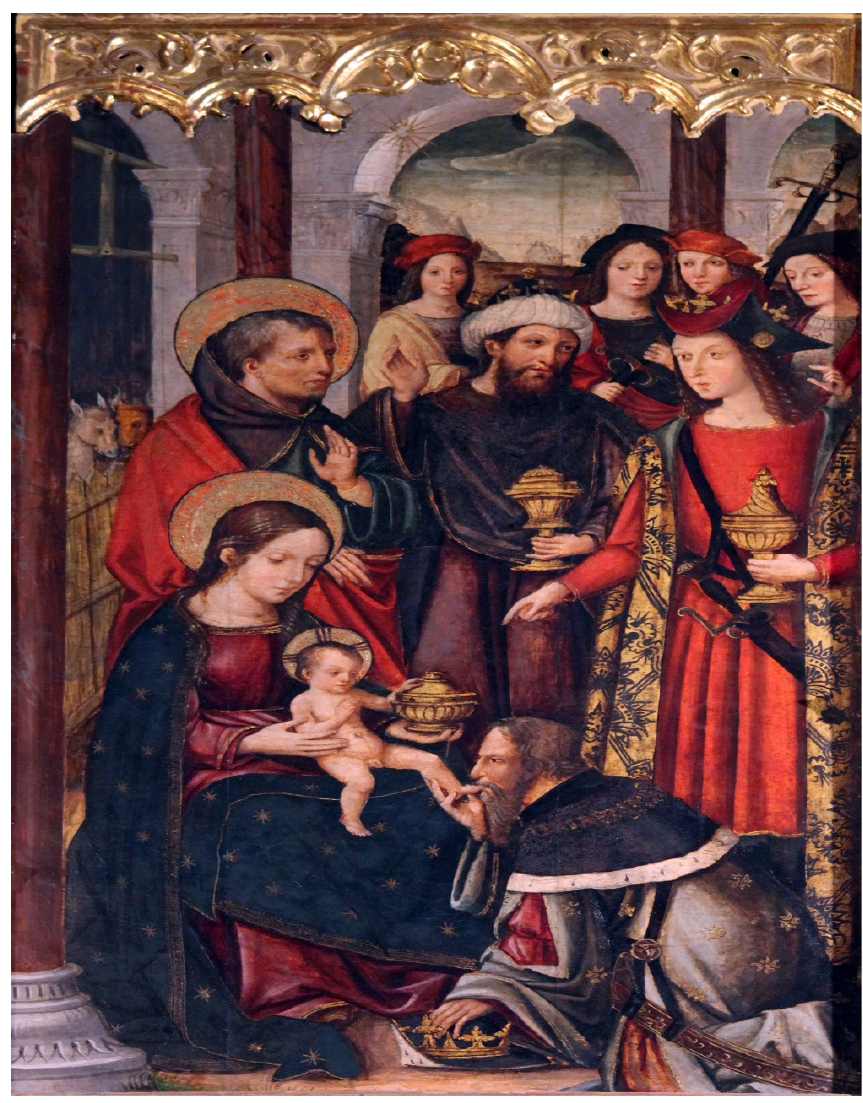
Figure 2. Adoration of the Magi.